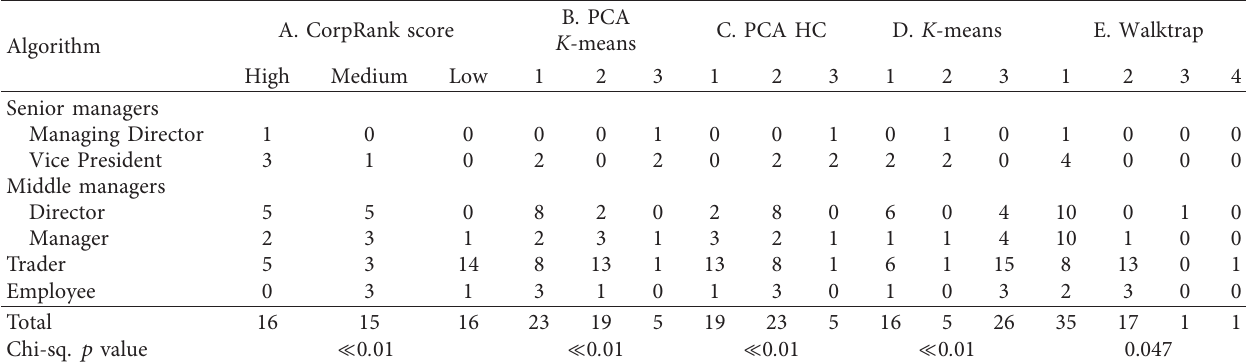
Table 4: Distribution of Enron North American West Power Trading’s employees in occupational categories by A. CorpRank score, B. PCA K -means, C. PCA Hierarchical cluster (PCA HC), D. K -means, and E. Walktrap algorithm. Chi-square’s p value compares the results with the expected values assuming that there is independence between the occupational categories and the clusters generated by each